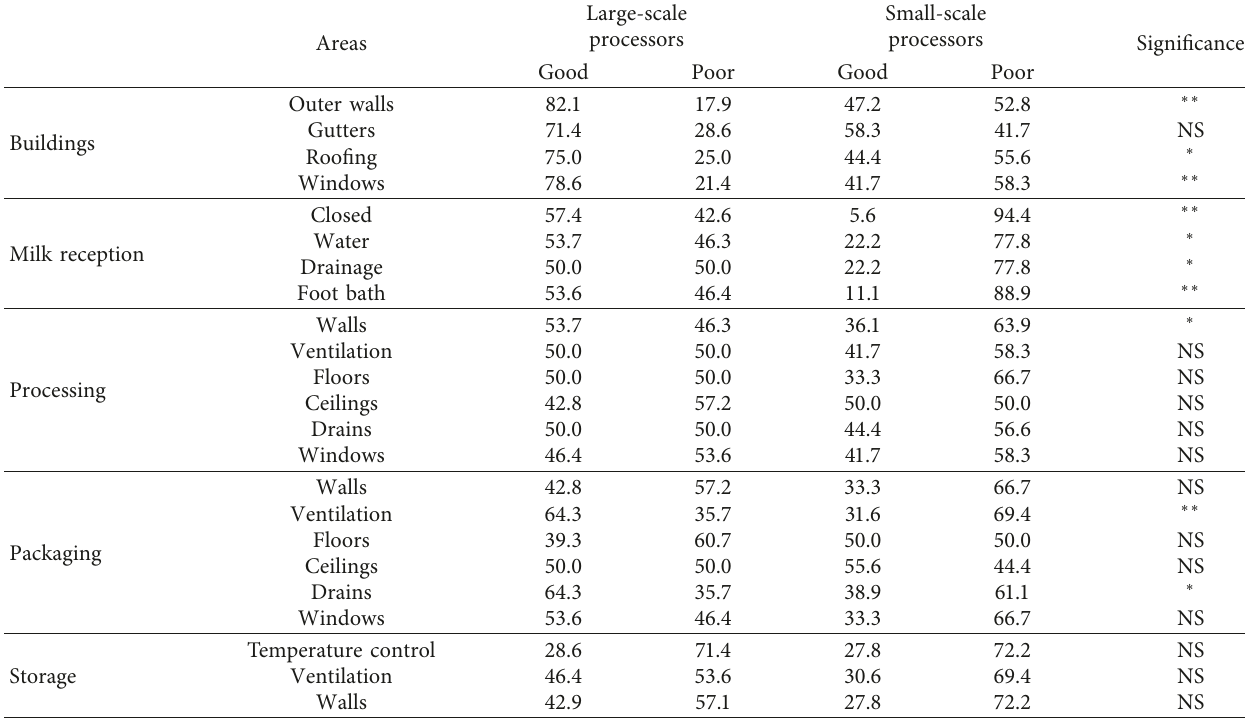
Table 1: Frequencies (%) of structural condition of processing facilitates of small-scale and large-scale dairy processors.